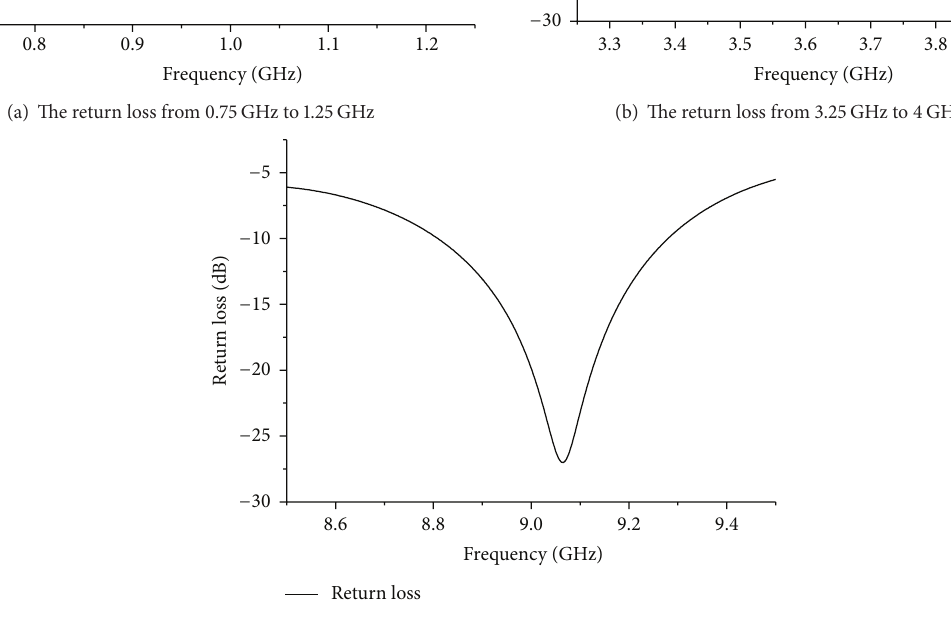
(c) The return loss from 8.5GHz to 9.5GHz Figure 7: The return loss of the two-layer Sierpinski patch antenna. (a) The return loss from 0.75 GHz to 1.25 GHz. (b) The return loss from